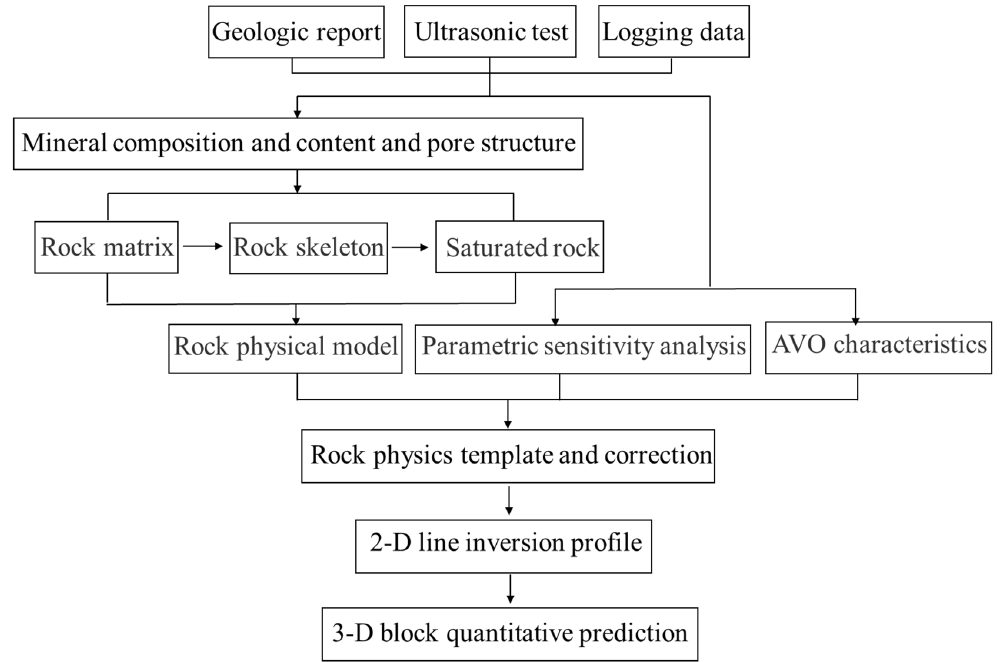
Figure 5. Flowchart for the prediction of the reservoir properties.